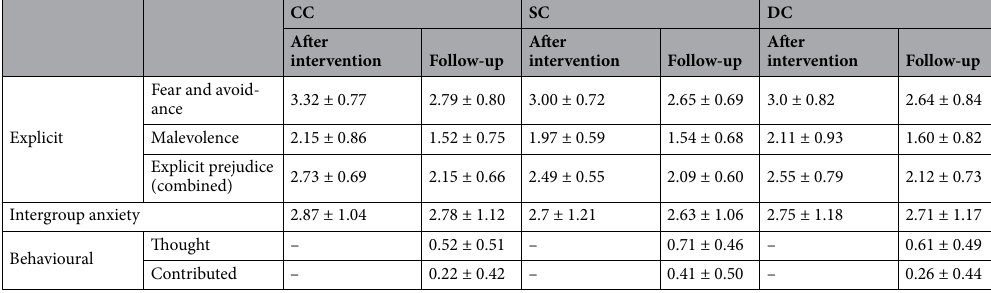
Table 4. Descriptive statistics on our sample, at the end of the experiment and at the 1-week follow-up, per condition, for explicit and behavioural prejudice